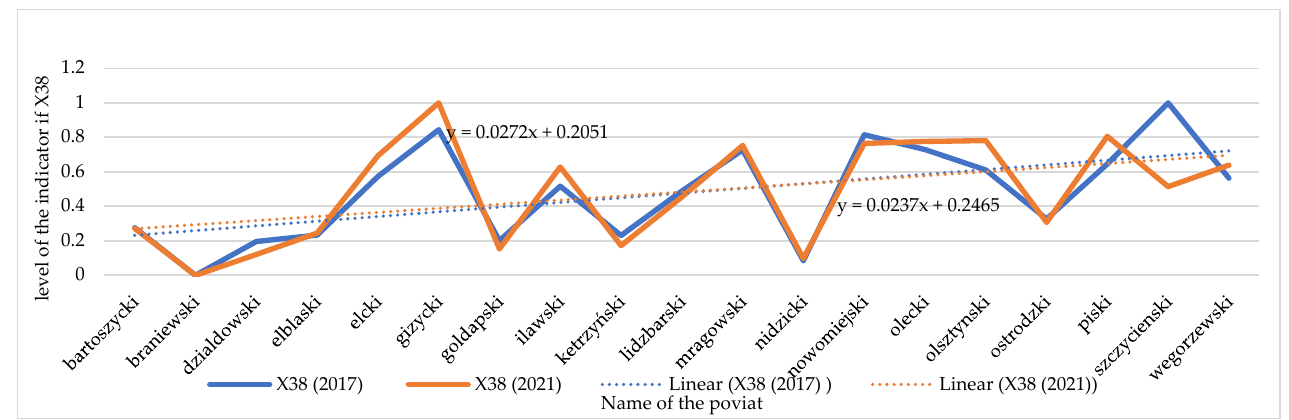
Figure 8. Changes in the index of the electricity consumption/ per person (X38) in individual spatial units. Source: own study on [106].